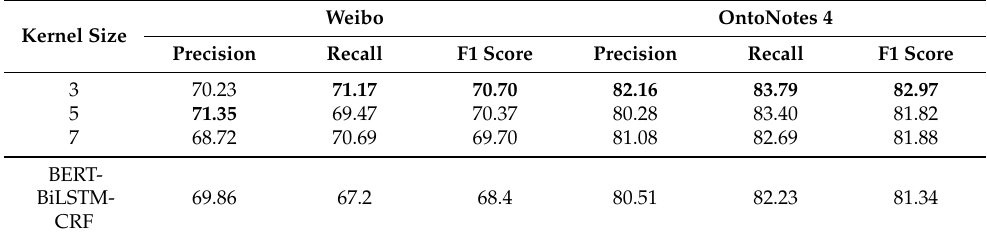
Table 7. Performance of CGR-NER under different kernel sizes.